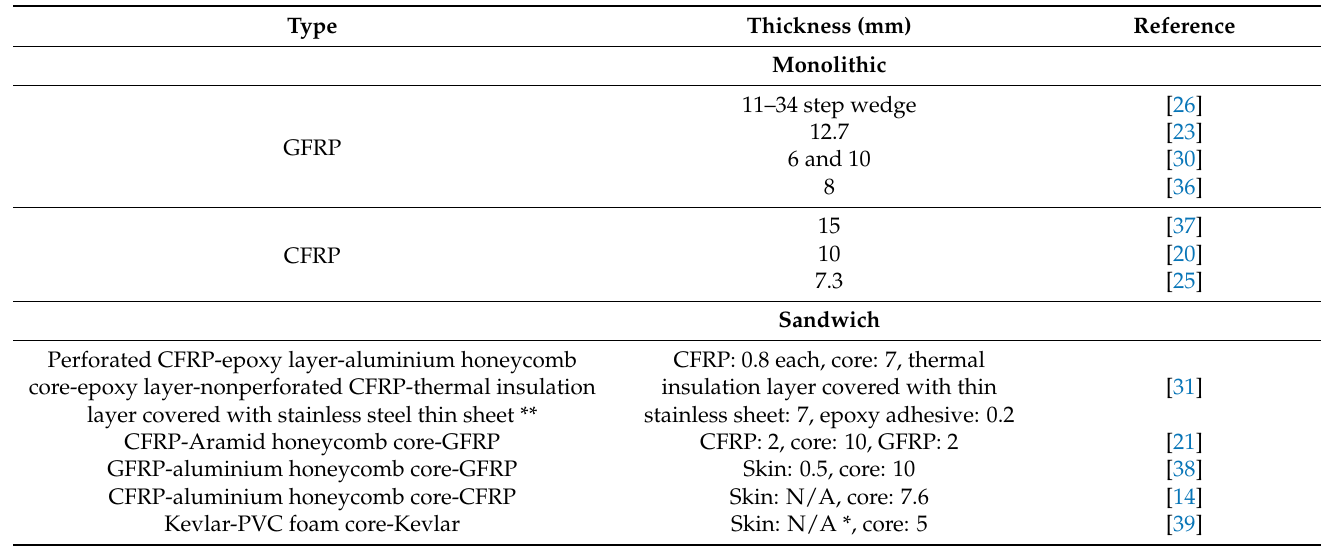
Table 1. Brief overview of research covering IRT inspection of thick monolithic and sandwich composite components listed by size of